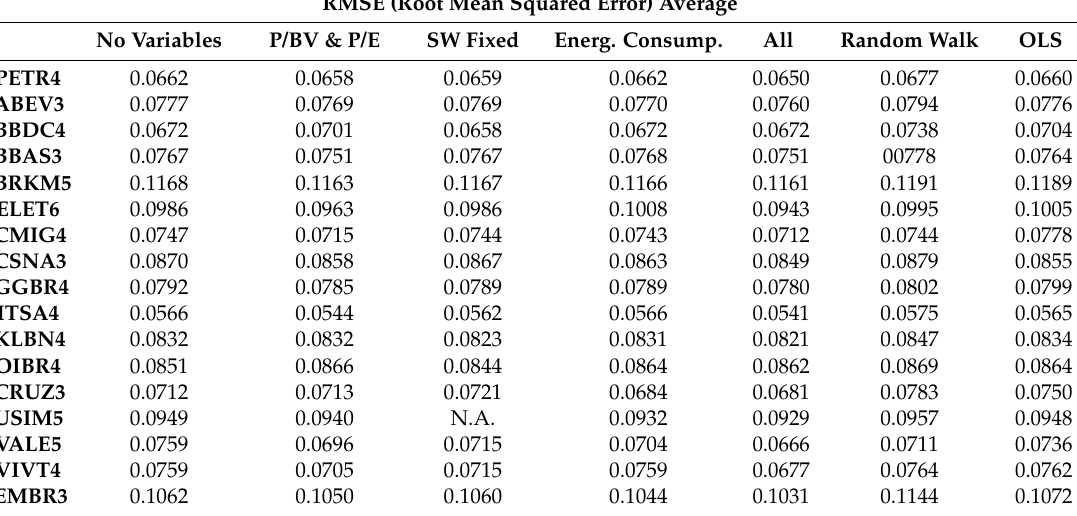
Table 4. Result: root mean squared error.